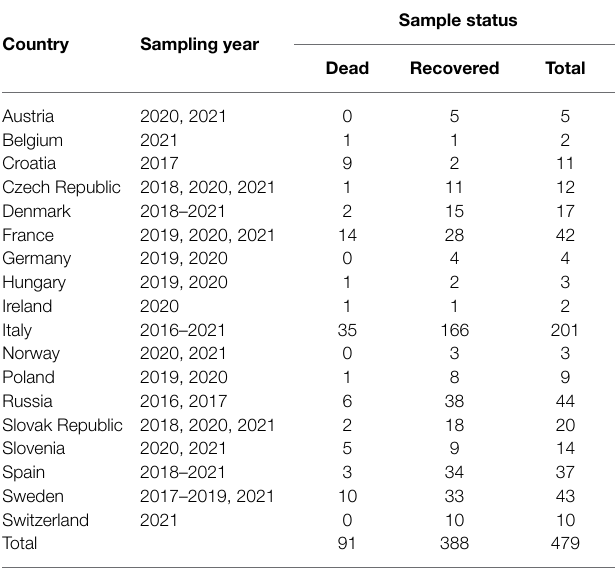
TABLE 1 | Number of dead and recovered stem rust samples collected between 2016 and 2021.